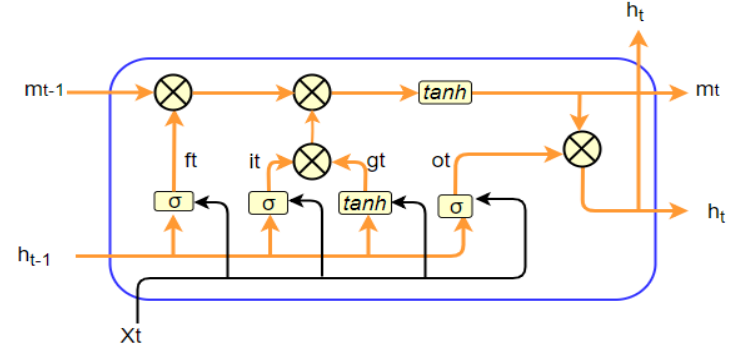
Figure 3. Long short-term memory (LSTM) Structure.